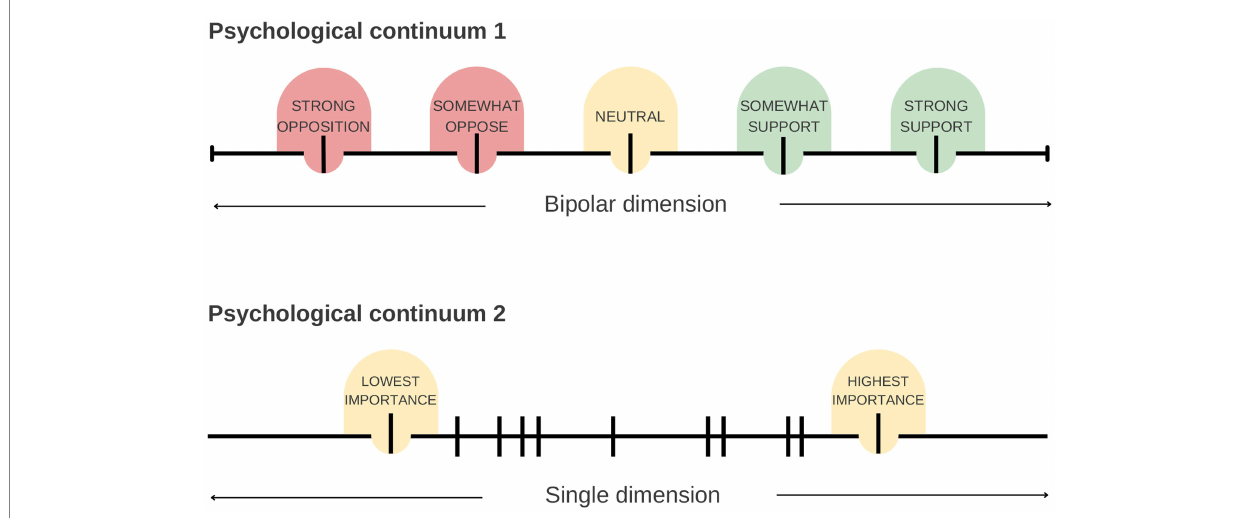
FIGURE 7 Two example psychological continua that could be examined using a survey in health professions education (HPE) research. As in the case study of this paper, the “importance” of different entities can be considered in a single dimension, with the importance of measured entities as relative to each other. This is well suited to measurement using pairwise comparison questions and the Elo algorithm. Some researched dimensions, though, are bidirectional and span from one extreme (e.g., opposition) to the other (e.g., support). Measurement of different entities on this scale is better suited to Likert items, which can measure both aspects of the dimension absolutely. In contrast, the outcomes of pairwise comparisons measuring “support” would not measure active opposition, only relatively less